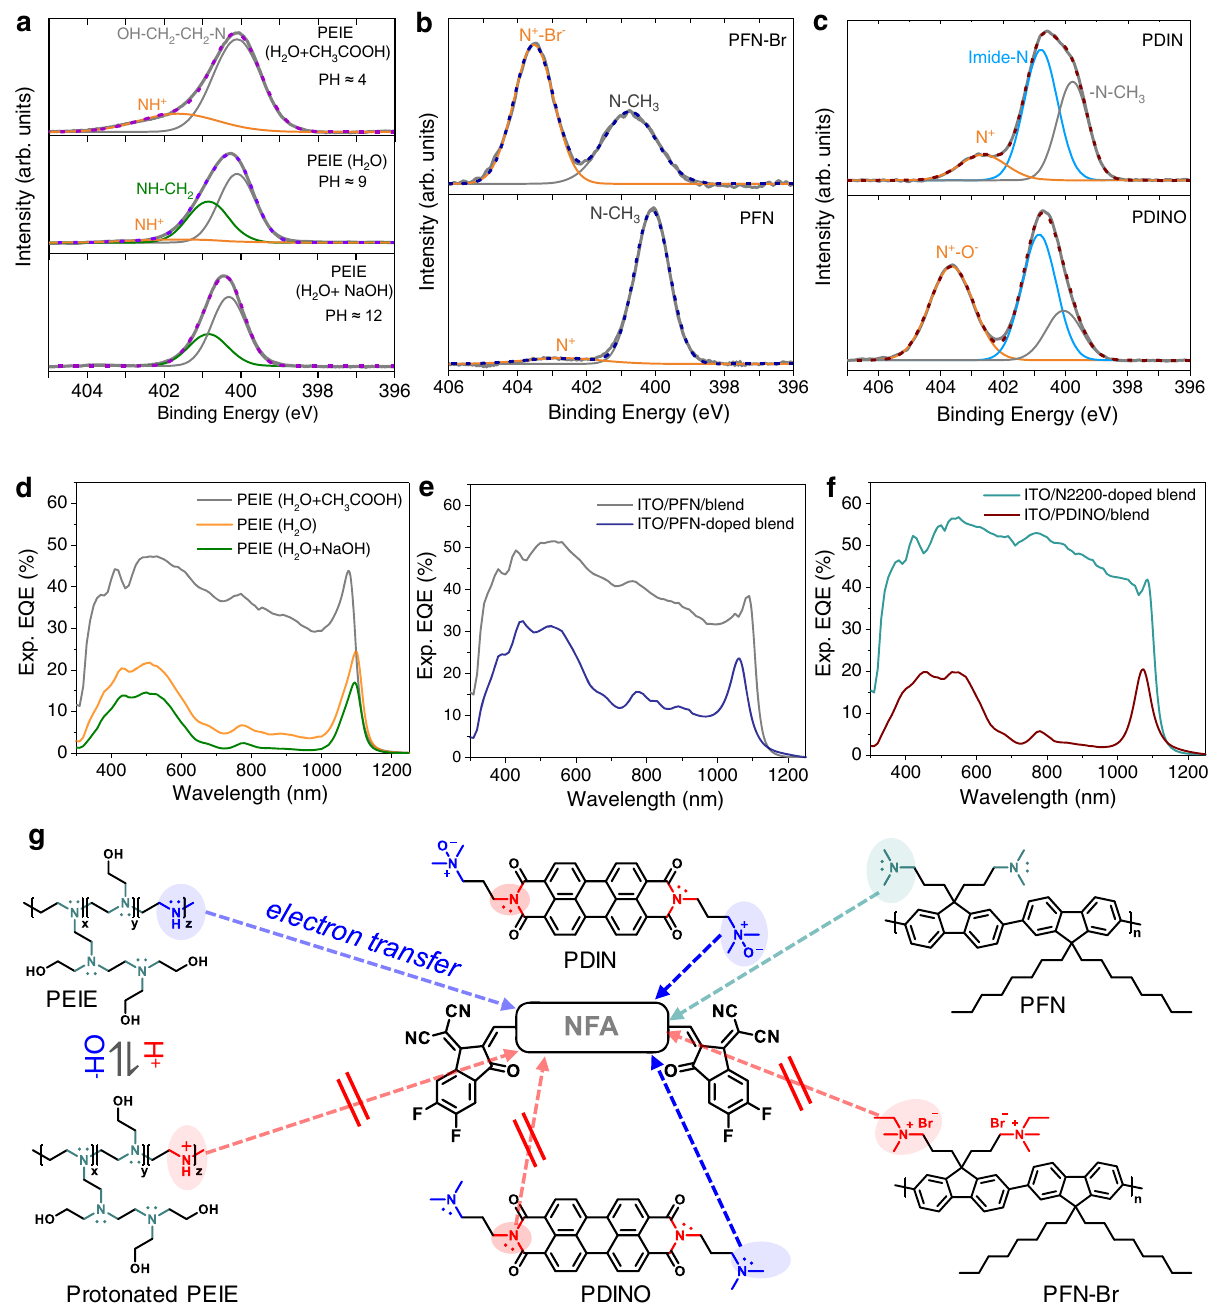
Fig. 3 | Mechanistic study of n-doping between various ETLs and active layers containingnonfullereneacceptors. DeconvolutionoftheN 1s peakinXPSspectra of different ETLs coated on ITO substrates: ( a ) PEIE processed using different conditions: 1.0vol% CH 3 COOH and 1.0vol% NaOH solution (40mg/mL in H 2 O) were added in a 6mg/mL PEIE (H 2 O) solution to tune the pH value to be around 4 and12,respectively.NotethatallthePEIEsampleswerethermallyannealedat80°C in a glovebox for 10min beforeperforming XPS measurements. b PFN-Br and PFN. c PDIN and PDINO. The experimental N 1s curves (bold gray lines) are as-recorded